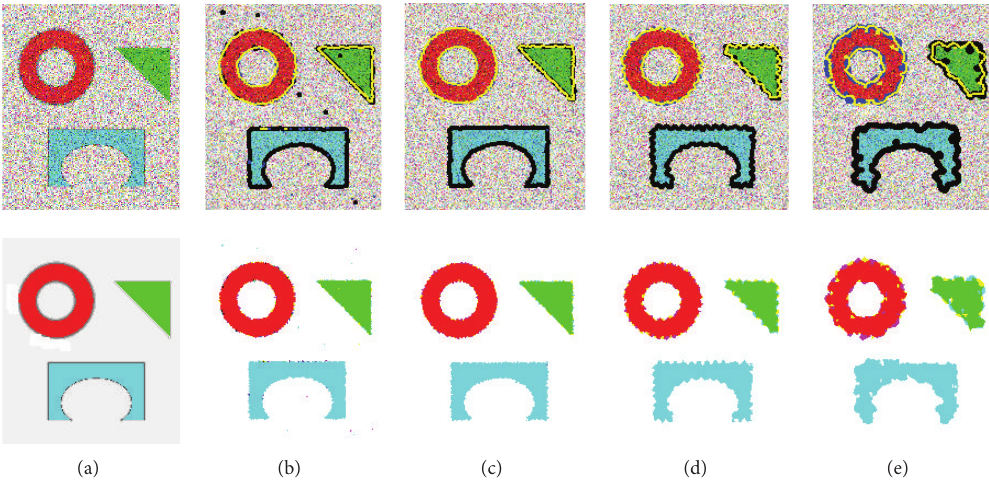
Figure 11: Segmentation results using localizing radii 1, 2, 5, and 9, respectively. (a) Synthetic image with Gaussian noise with variance 0.1 (upper row) and the ground truth image; (b)–(e) the corresponding final results and the segmentation results using radii 1, 2, 5, and 9, respectively.